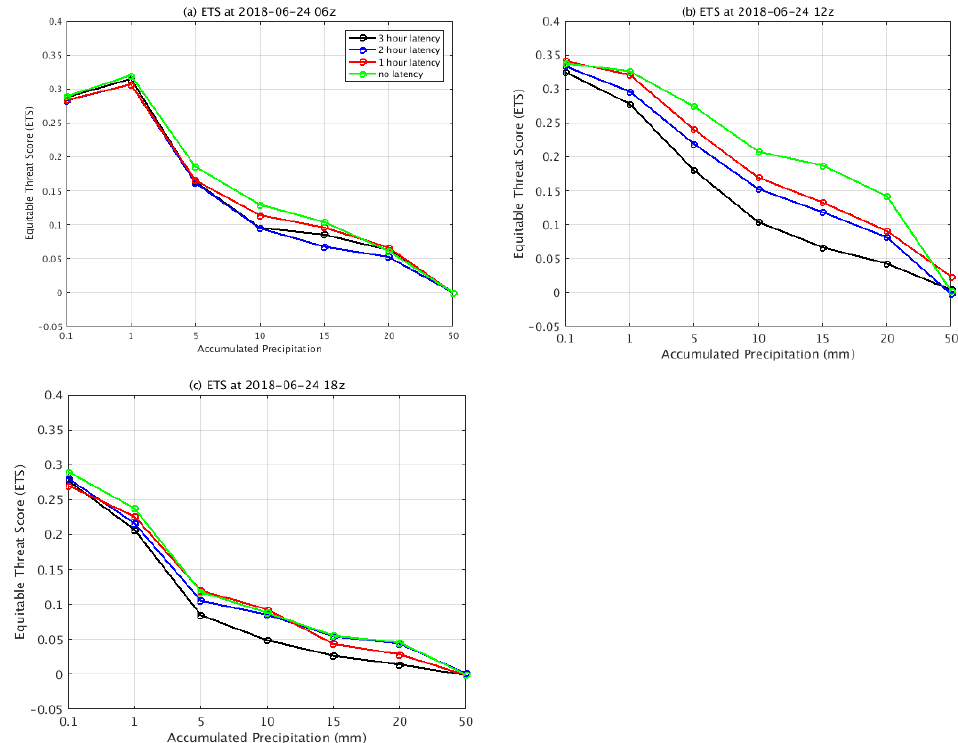
Figure 6. ETS of the 6-h forecasts ( a ), 12-h forecasts ( b ) and 18-h forecasts ( c ) for the experiments of 3-h latency (black), 2-h latency (blue), 1-h latency (red) and no latency (green), respectively.